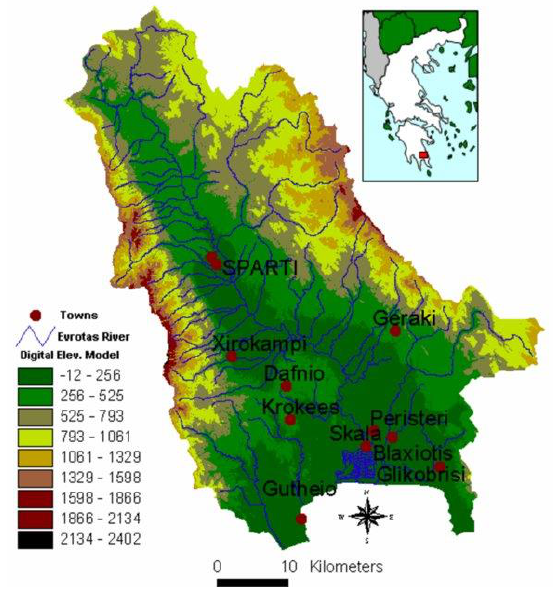
Figure 3. The Evrotas river basin [26]